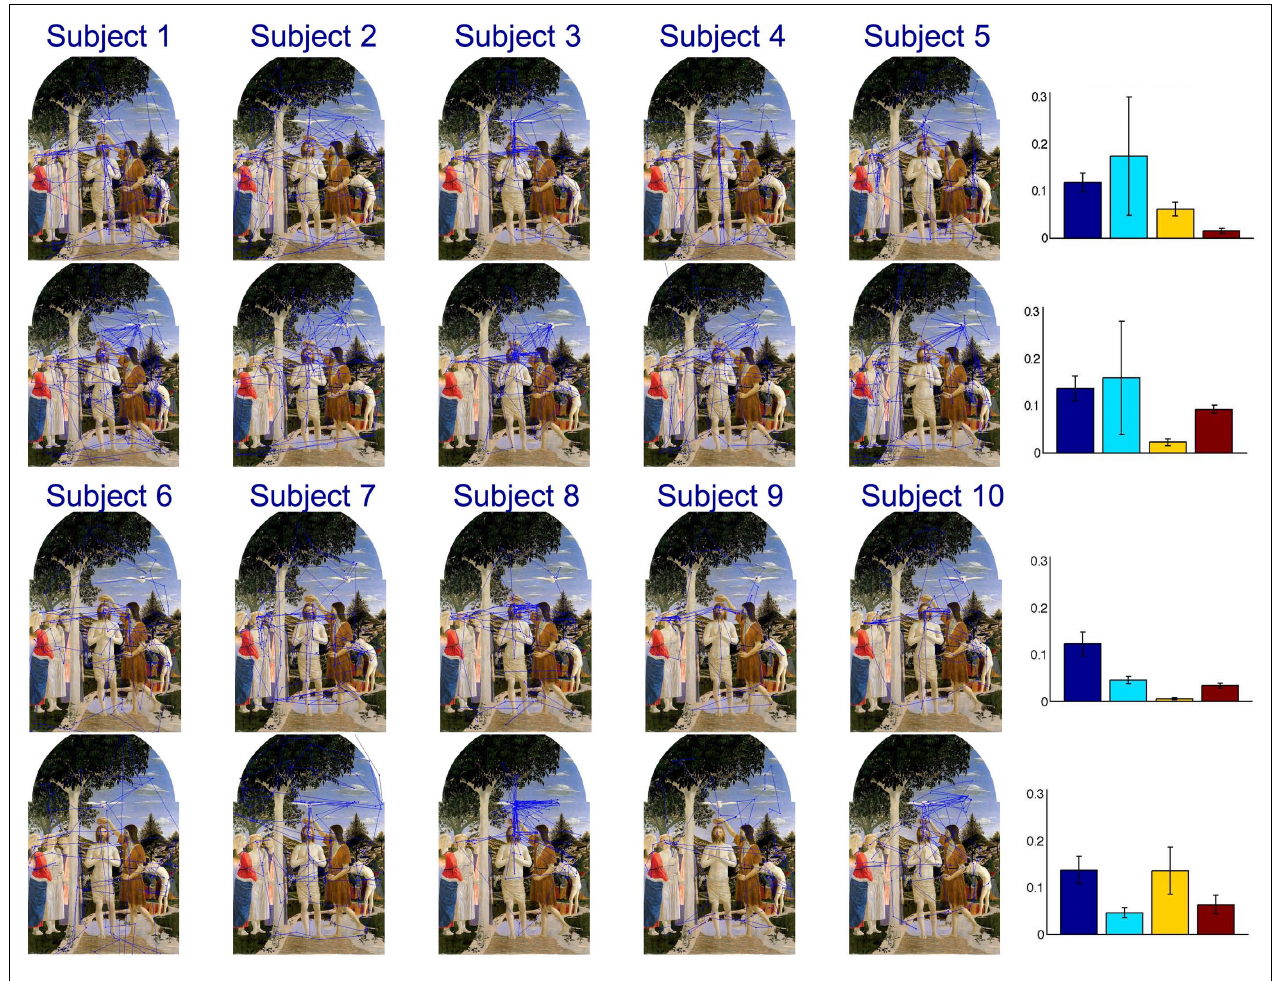
original (modified) version first.The graphs on the right of each row show the average relative number of fixations in each region of interest for the five